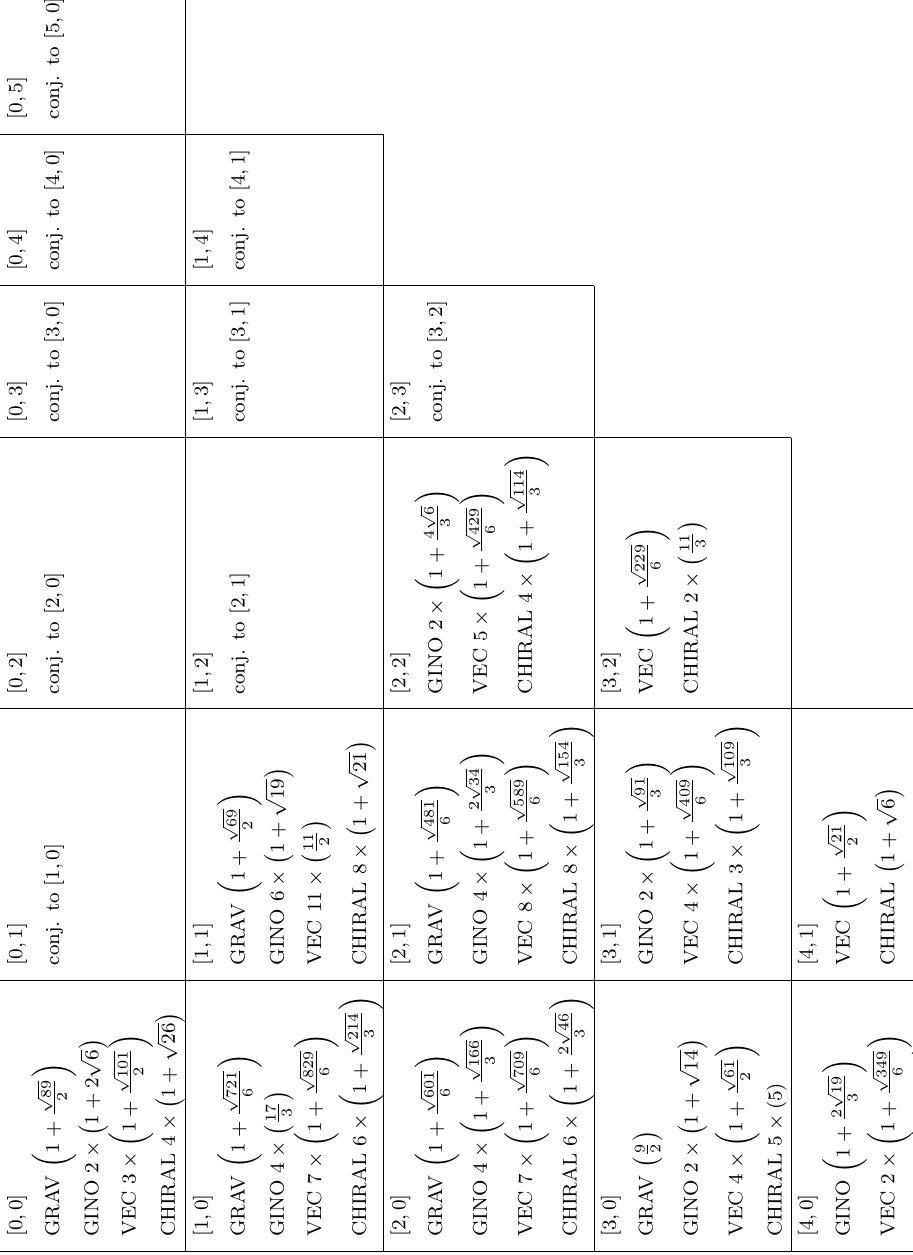
Table 15 . Supermultiplets at KK level n = 3 for the N = 1 SU(3)-invariant AdS 4 solution of